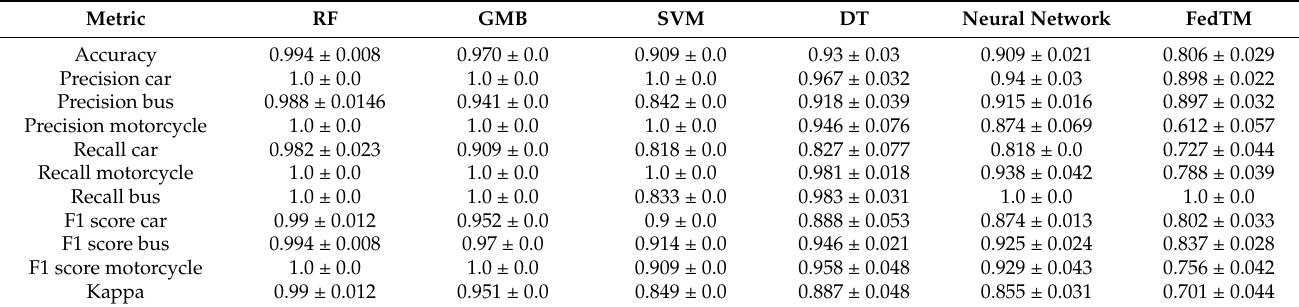
Table 5. Metrics of FedTM and centralized classifiers on transport mode